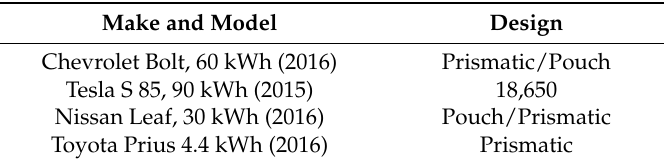
Table 9. List of battery types and designs. [10–14]